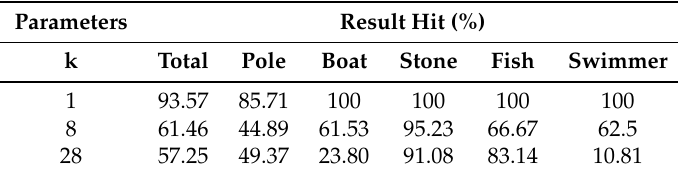
Table 12. Balanced 10D Feature results—K-Nearest